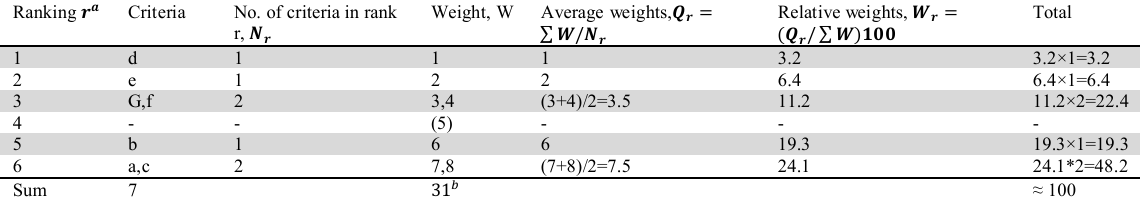
Simos Method for calculating criteria weights (Cavallaro,